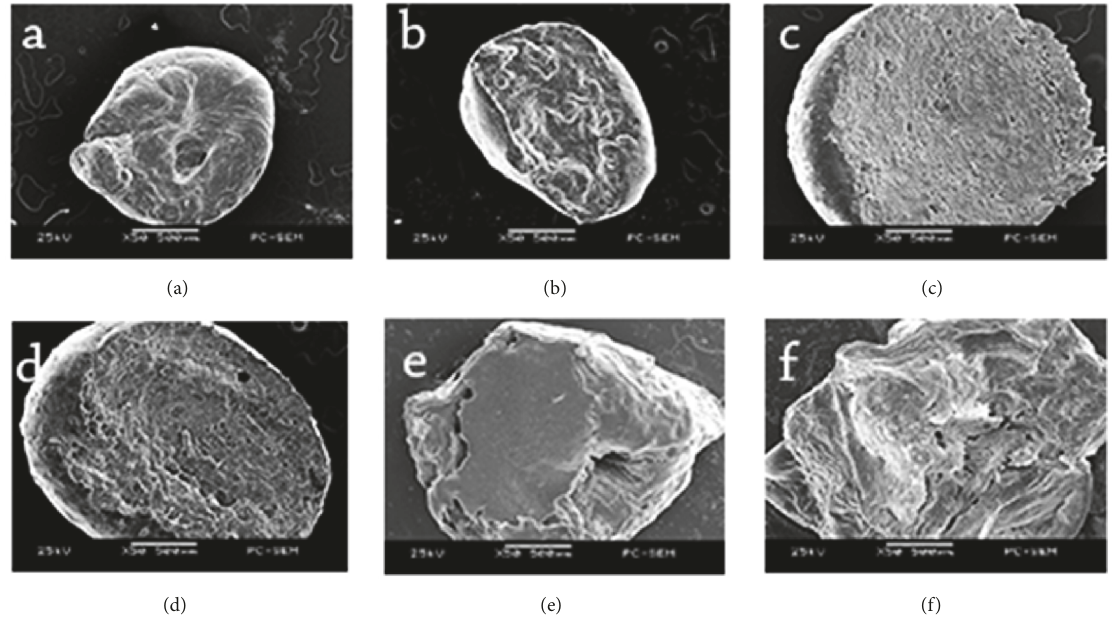
Figure 2: SEM micrographs showing the cross-sectional morphology of spirulina-alginate beads at 50x magnification made with (a) EG: alginate 1%, CaCl 2 10%, (b) EG: alginate 1%, CaCl 2 15%, (c) EG: alginate 7%, CaCl 2 10%, (d) EG: alginate 7%, CaCl 2 15%, (e) IG: alginate 0.5%, CaCl 2 2%, and (f) IG: alginate 1.5%, CaCl 2 2%.